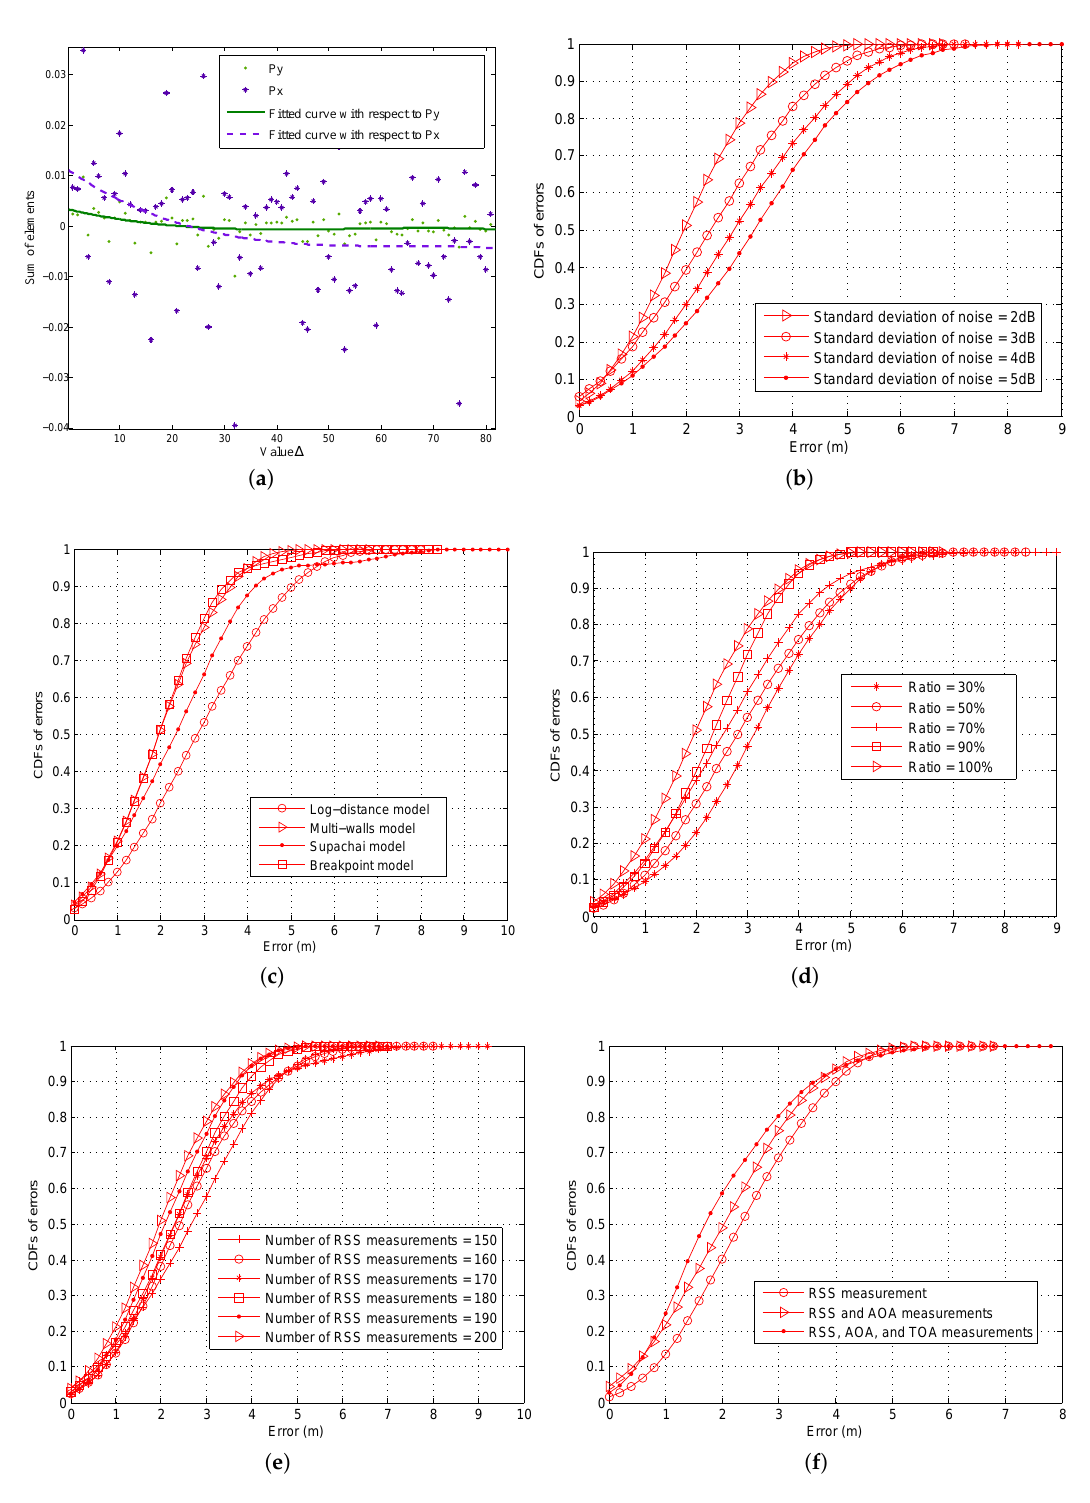
Figure 3. Parameter discussion in simulation. ( a ) Sum of elements in P x and P y under different values ∆ ; ( b ) CDFs (Cumulative Distribution Functions) of errors under different noise perturbations; ( c ) CDFs of errors under different signal attenuation properties; ( d ) CDFs of errors under different numbers of calibrated locations; ( e ) CDFs of errors under different numbers of RSS measurements; ( f ) CDFs of errors by using different types of measurements for